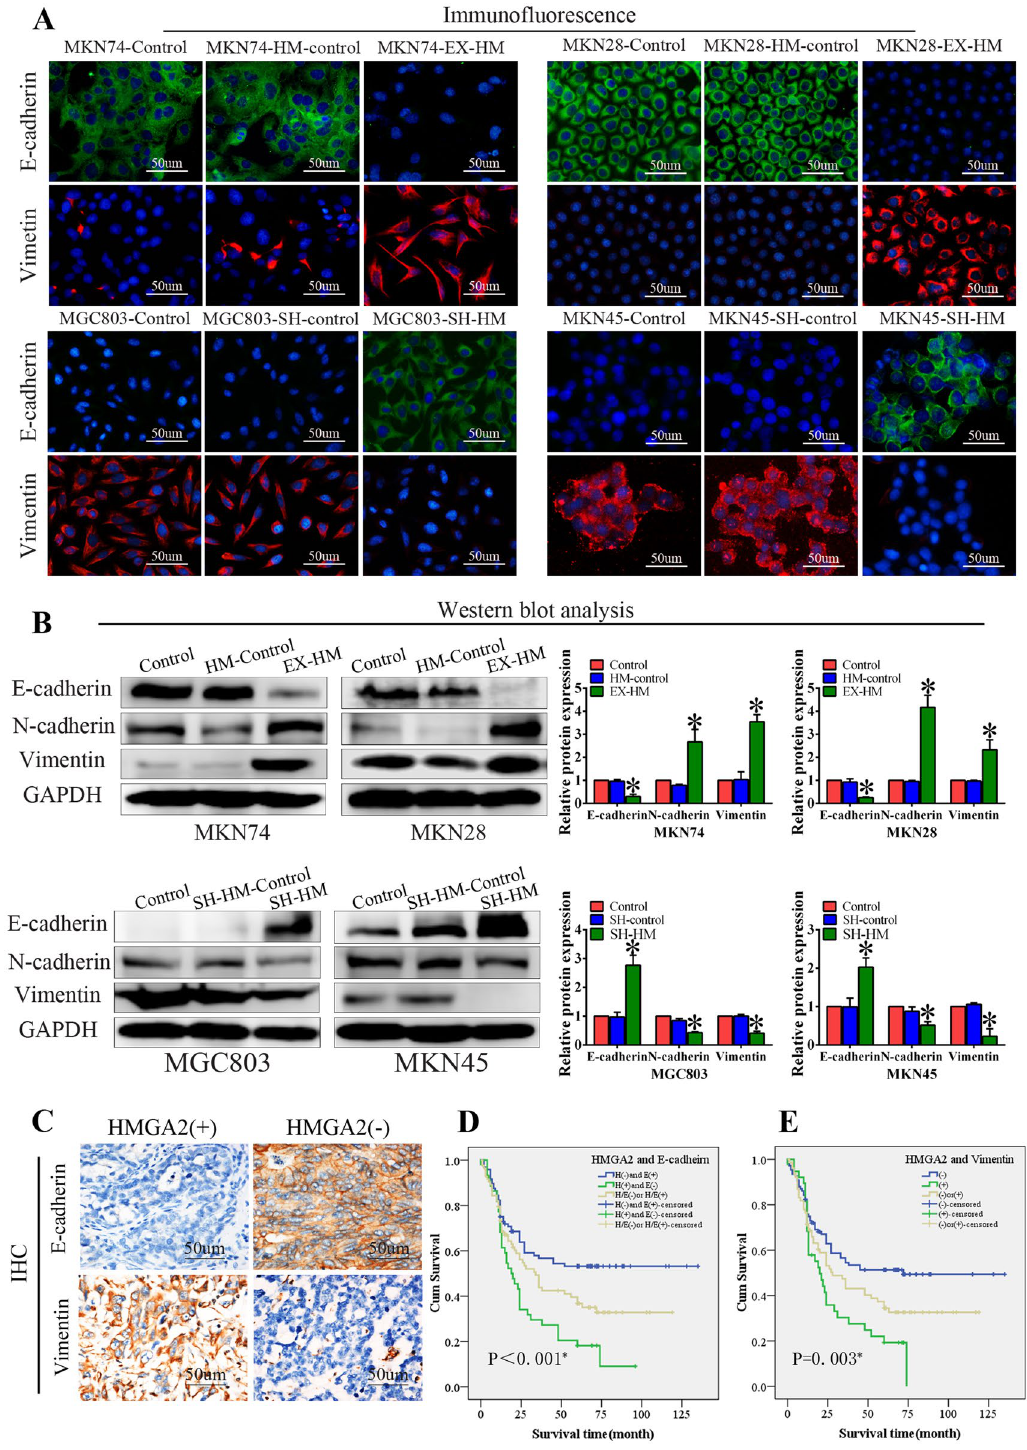
Figure 5. HMGA2 is associated with the EMT signaling. MKN74 and MKN28 cells stably transfected with HMGA2 expression plasmid and MGC803 and MKN45 cells stably transfected with HMGA2 sh-RNA plasmid. ( A ) Immunofluorescence staining. Overexpression of HMGA2 increased the protein expression of vimentin and inactivated the expression of E-cadherin and HMGA2 silencing inhibited vimentin expression and upregulated E-cadherin expression (bar, 50 um). ( B ) Western blot showed that expression of E-cadherin and vimentin, N-cadherin in GC cell lines ( * P < 0.05). ( C ) IHC staining showed the expression of E-cadherin and vimentin in GC samples ( × 200, bar 50 um). ( D , E ) Kaplan-Meier survival analysis of GC patients categorized by a combination of HMGA2 and E-cadherin ( D ), vimentin ( E ) ( * P <